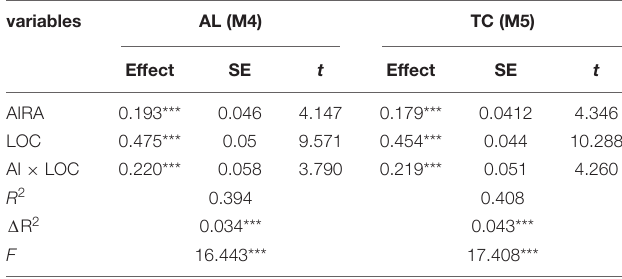
TABLE 7 | Results of moderating effect test.